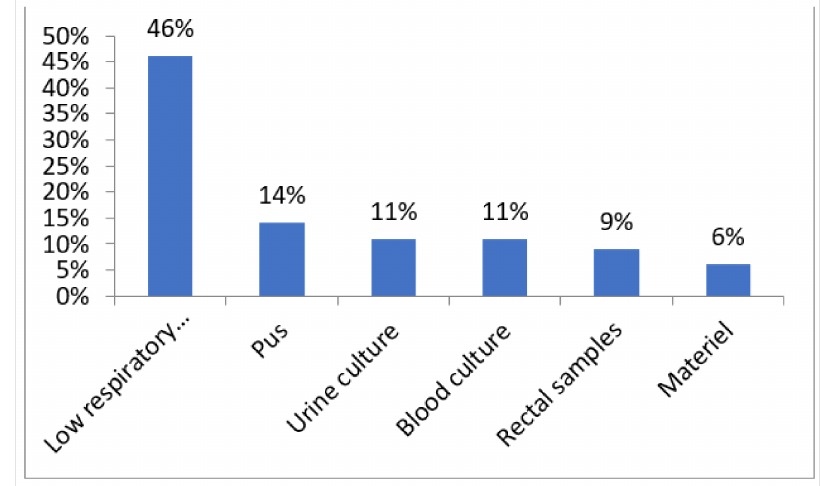
Figure 2. Distribution of P.aeruginosa isolates according to sample types.